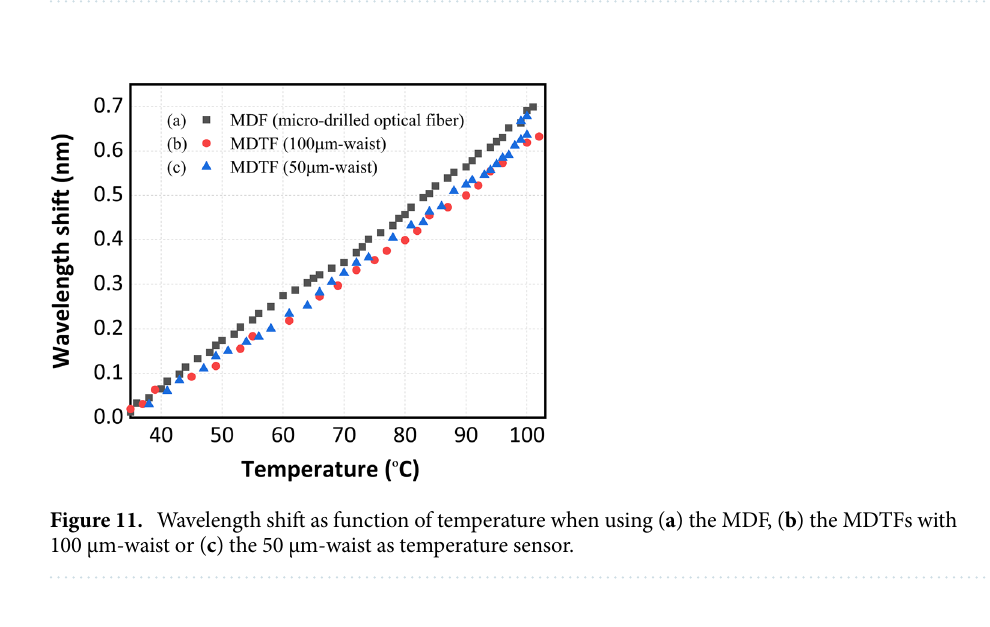
Table 1. Comparison of laser generation properties when using a micro-drilled fiber (MDF), a 50 μm-waist or a 100 μm-waist micro-drilled tapered as a reflector (MDTF).